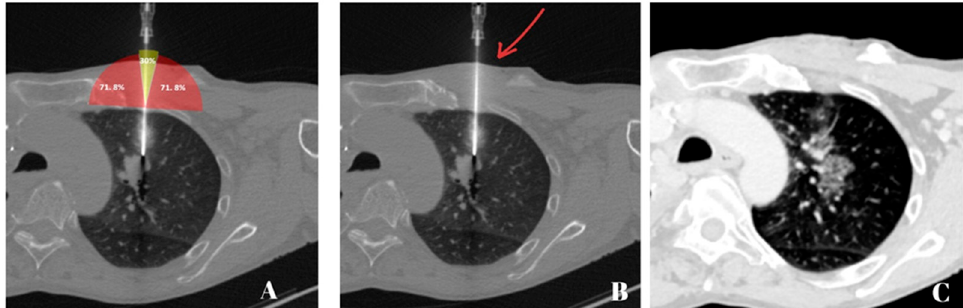
Figure 5. Different axial CT images of the same patient at 75 mA, 120 kV, and a 2 mm slice thickness with a 1 mm increment: ( A ) A safe zone scheme was placed on the needle before it entered the pleura. The yellow triangle depicts δ min < 10 ◦ and the red triangles depict δ min ≥ 10 ◦ with a significantly higher incidence of pneumothorax (71.8% vs. 30%); ( B ) The same image as presented in ( A ) but without the safe zone scheme. The red arrow points to the needle that has entered the lung at a 90 ◦ angle to the pleura, aiming for the presented pulmonary mass in the upper left lobe; ( C ) Post-intervention control scan showing no evidence of